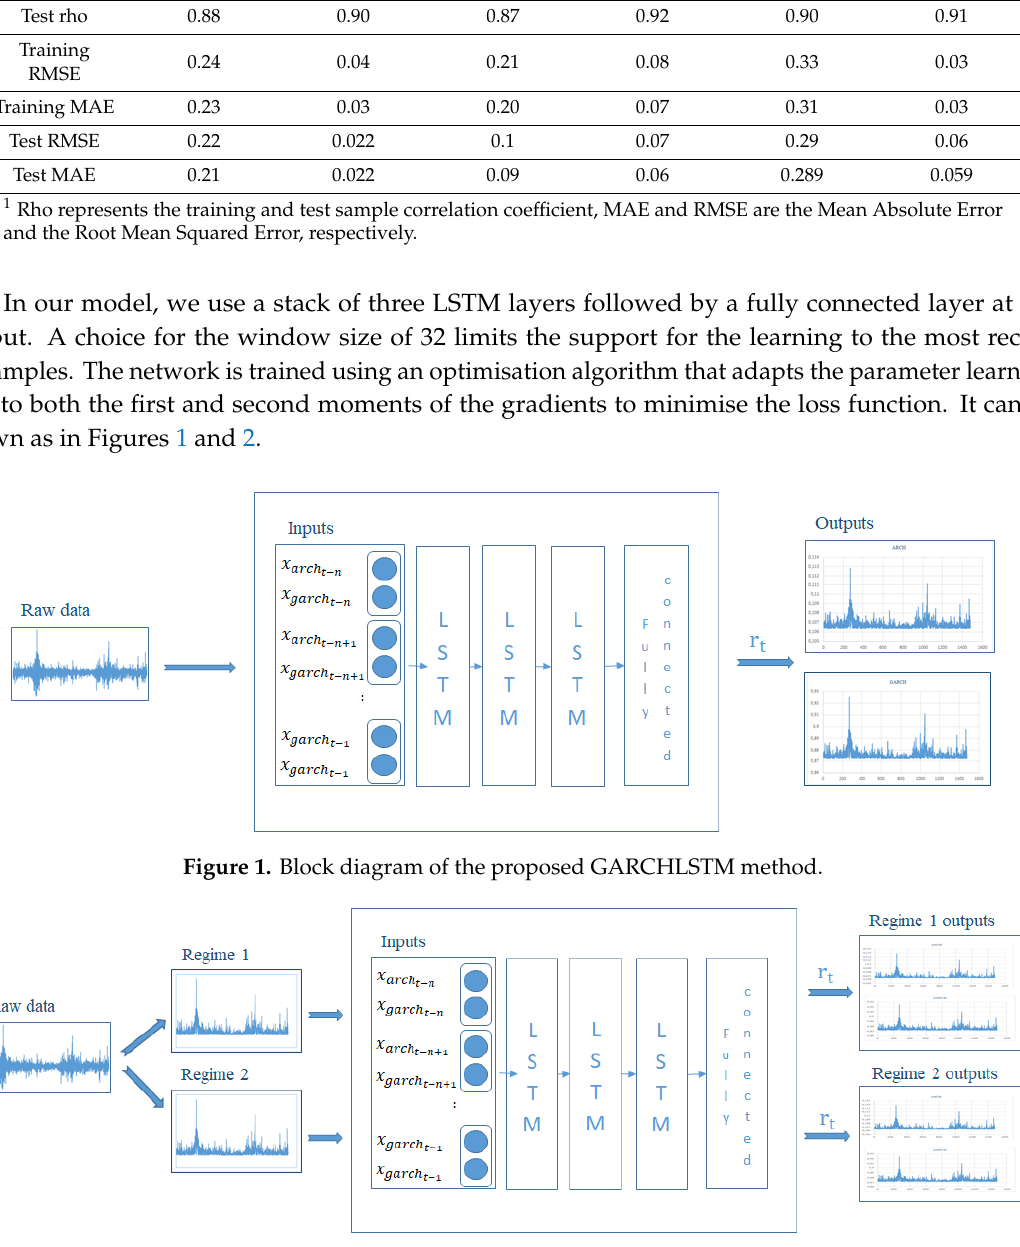
Figure 2. Block diagram of the proposed LSTARGARCHLSTM method.